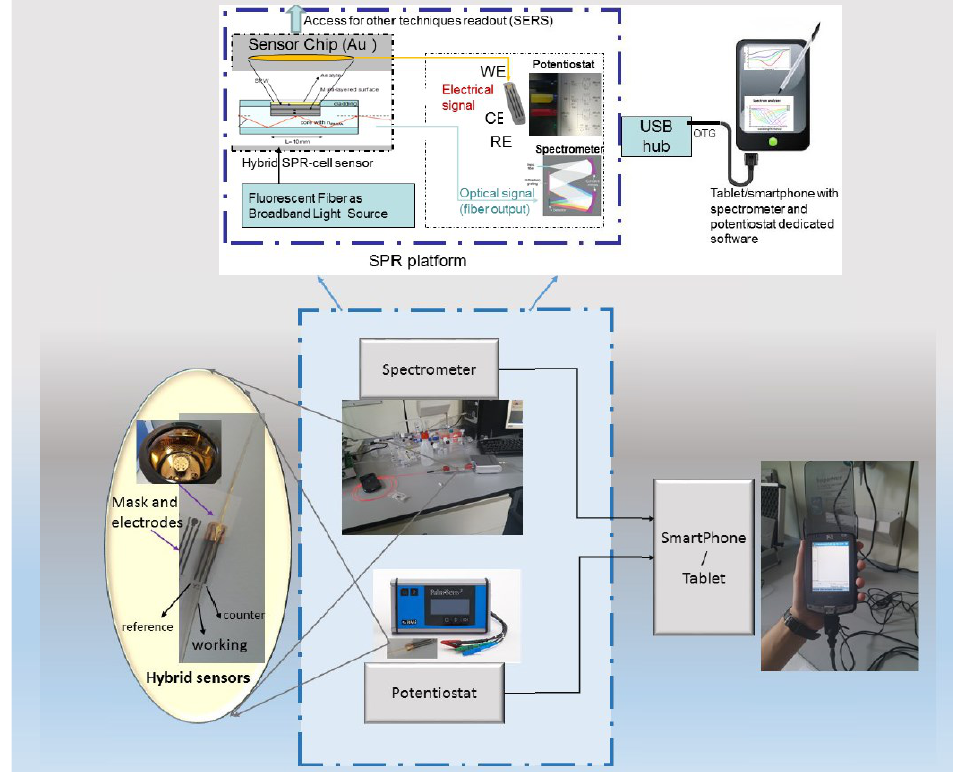
Figure 3. Scheme of the hybrid sensor platform developed [3].